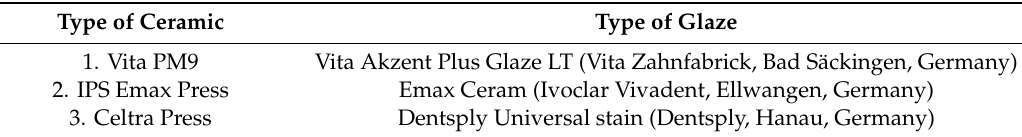
Table 4. Particular glaze for each